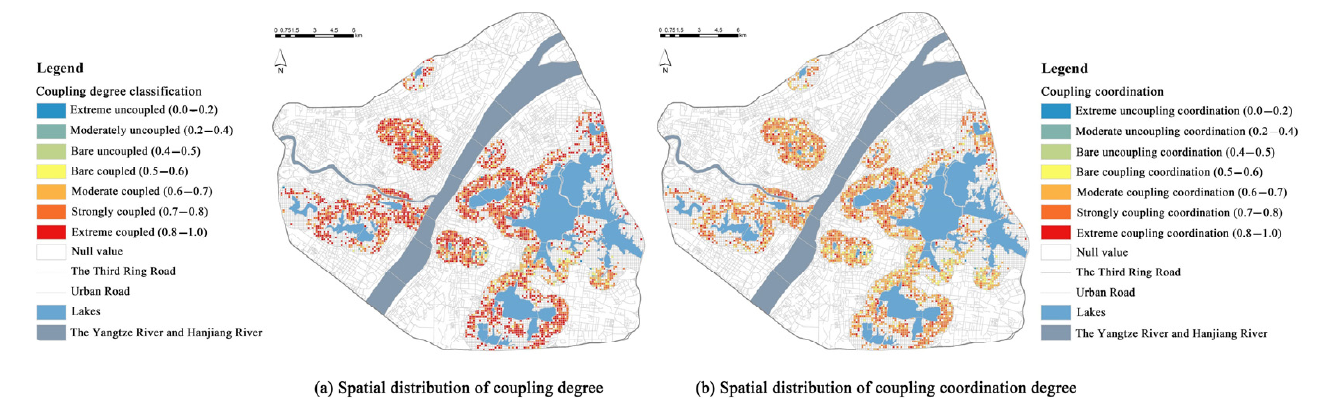
Figure 13. Spatial distribution of coupling degree and coupling coordination degree between spatial quality and public sentiment.